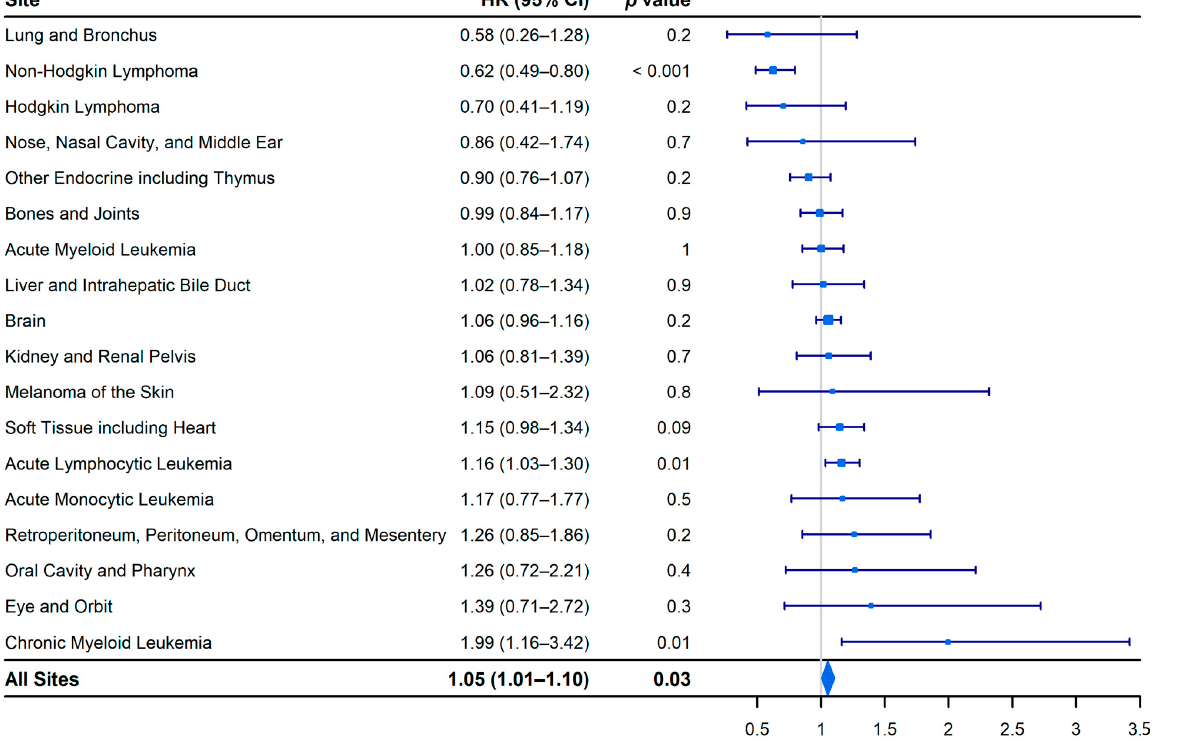
Figure 4. Forest plot of the site-specific hazard ratios of cancer-specific death for boys and girls (<15 years). Girls are the reference group.